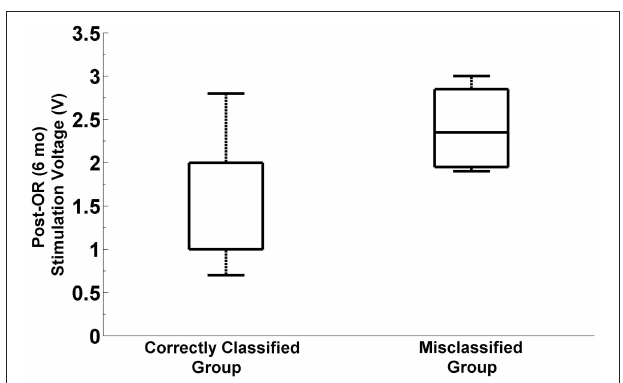
FIGURE 11 | Distribution of post-operative stimulation voltages in correctly classified and misclassified groups. Box plots show the stimulation voltages which were used in two groups during the programming 6 months after the surgery. The box plot on the right indicates the distribution of post-operative stimulation voltages in misclassified group by excluding the outlier subject with 1V stimulation. The difference between stimulation voltages in the correctly classified and misclassified group is marginally significant ( p = 0.068 , α =